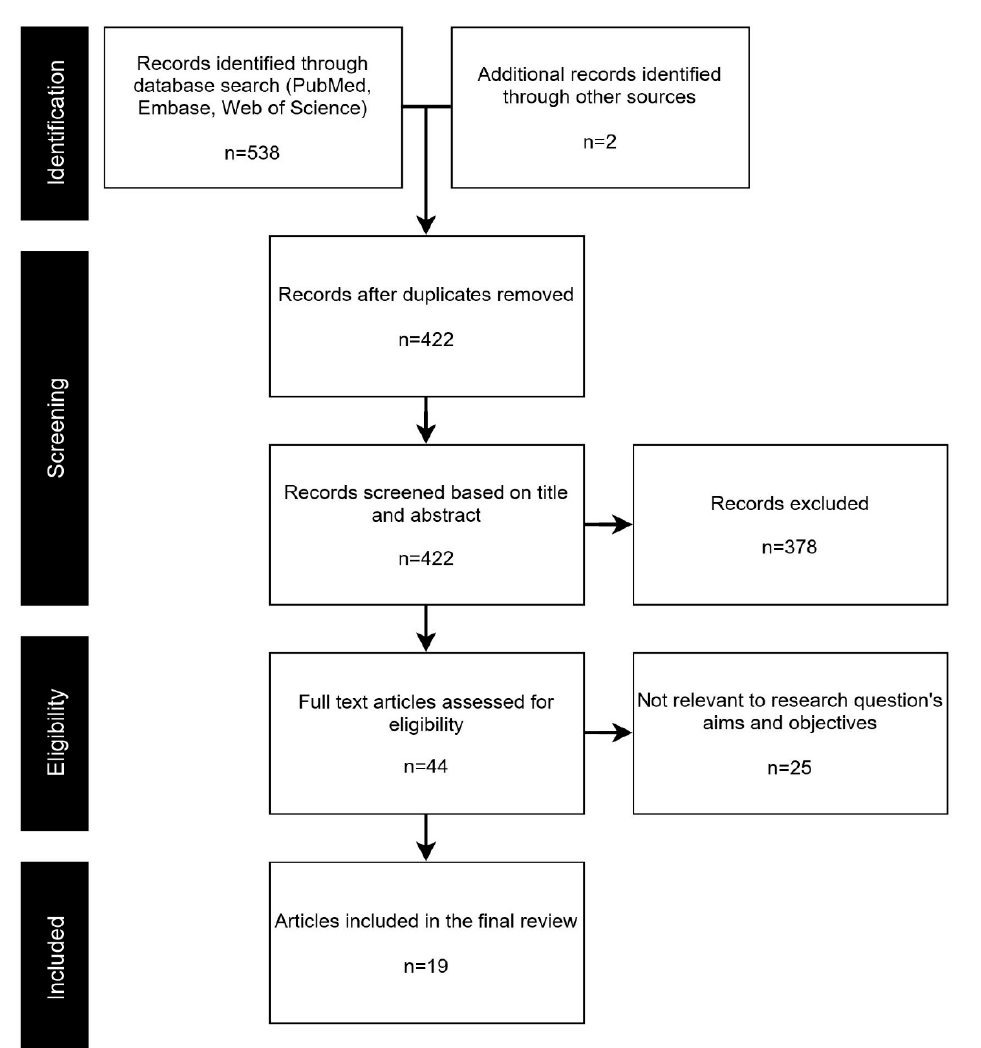
Figure 1. PRISMA study selection flowchart.